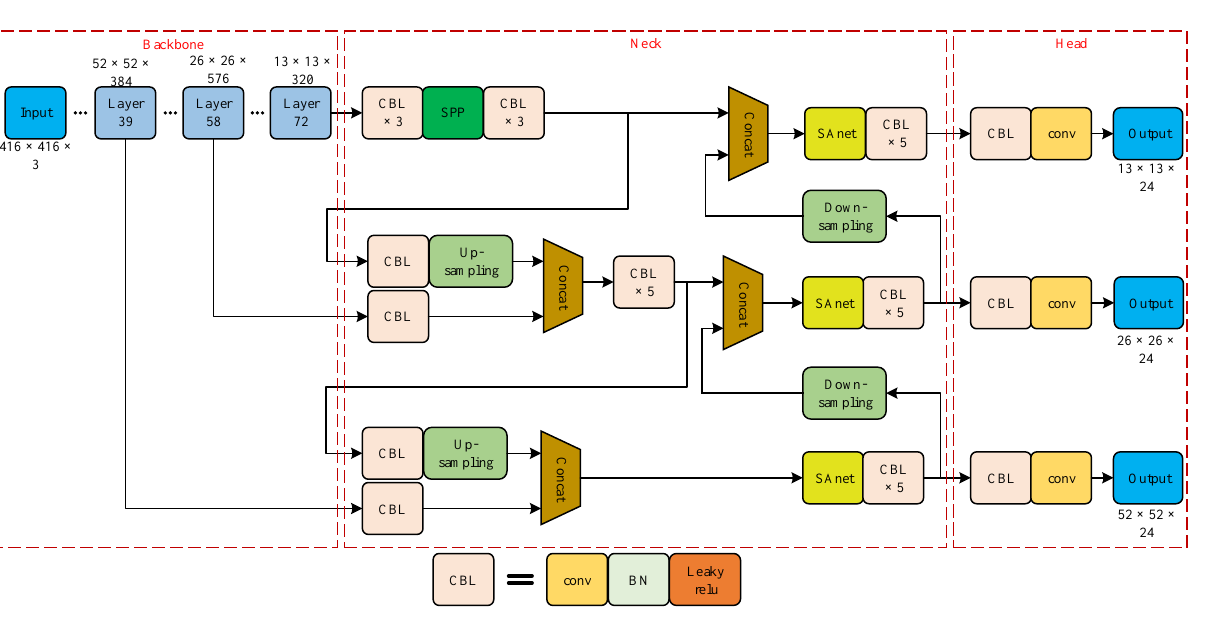
Figure 7. Improved network